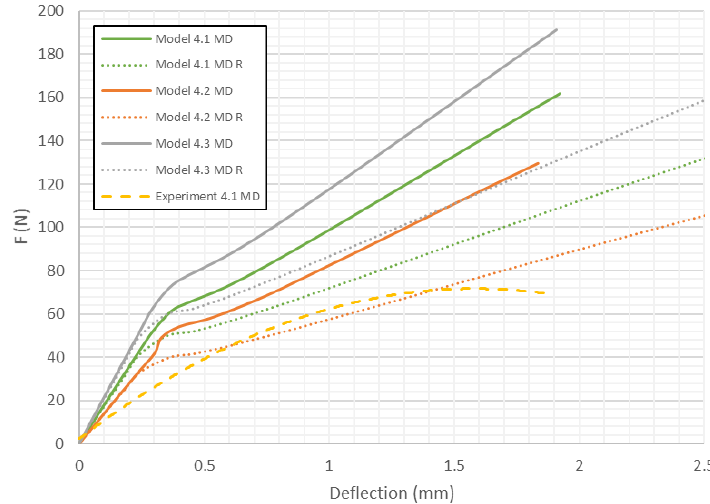
Figure 12. Deflection vs. force for Model 4 in MD.